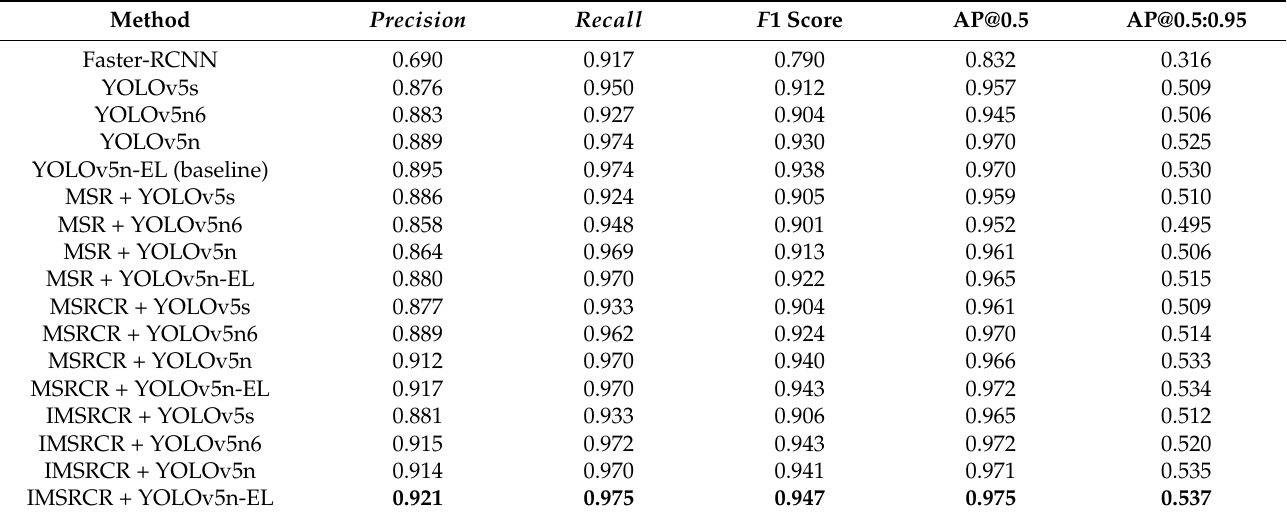
Table 1. The experimental